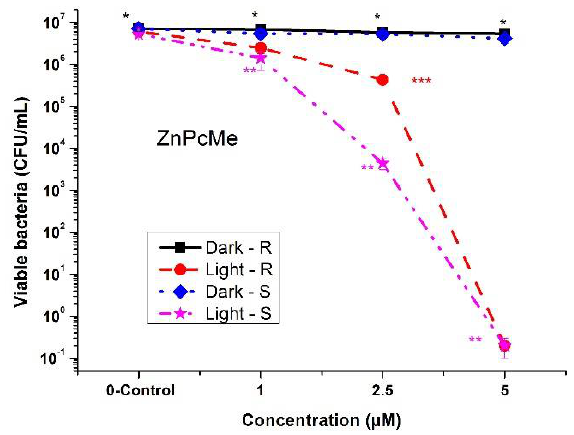
Figure 4. Photodynamic inactivation of A. hydrophila ( R and S ) planktonic cultured with Zn(II)- phthalocyanine (ZnPcMe) and an LED at 665 nm irradiation. * p < 0.005; ** p < 0.008, and *** p <